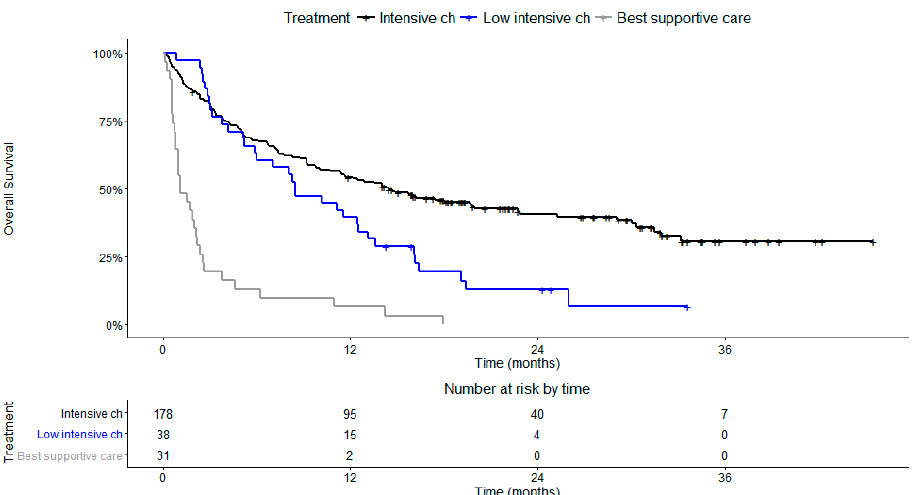
Figure 1. Kaplan–Meier curves for overall survival according to treatment. Intensive chemotherapy; low-intensive chemotherapy, including azacytidine and LDAC; and best supportive care (BSC).